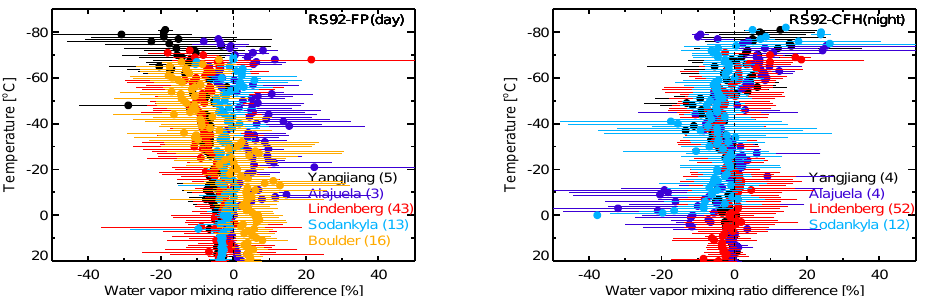
Figure 18. Comparison of humidity profiles from GRUAN-processed RS92 and coincident frost point (FP) hygrometer data. Top: daytime flights; bottom: night-time flights. Data are gridded in 500m wide bins and plotted with ambient temperature as the vertical scale. The analysis is restricted to the troposphere. The solid circles represent the relative difference RS92 – FP with respect to the FP humidity, and the bars indicate the statistical uncertainty (standard deviation). All data presented here are for the CFH except for the NOAA FPH data from Boulder; the number of soundings at each site is given in brackets. The approximate water volume mixing ratios at various temperature levels are given in Table 7.